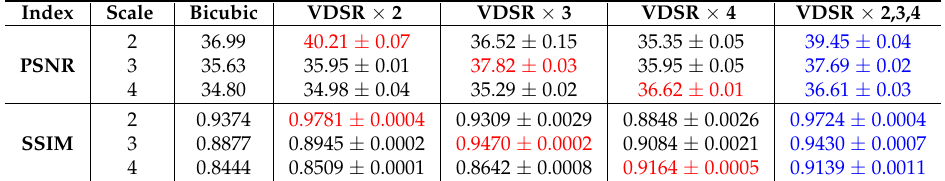
Table 8. Cross-scale experiments of VDSR trained and tested on BUAA-SID 1.0 (mean deviation). The red font indicates the best performance, while the blue font indicates the second best.